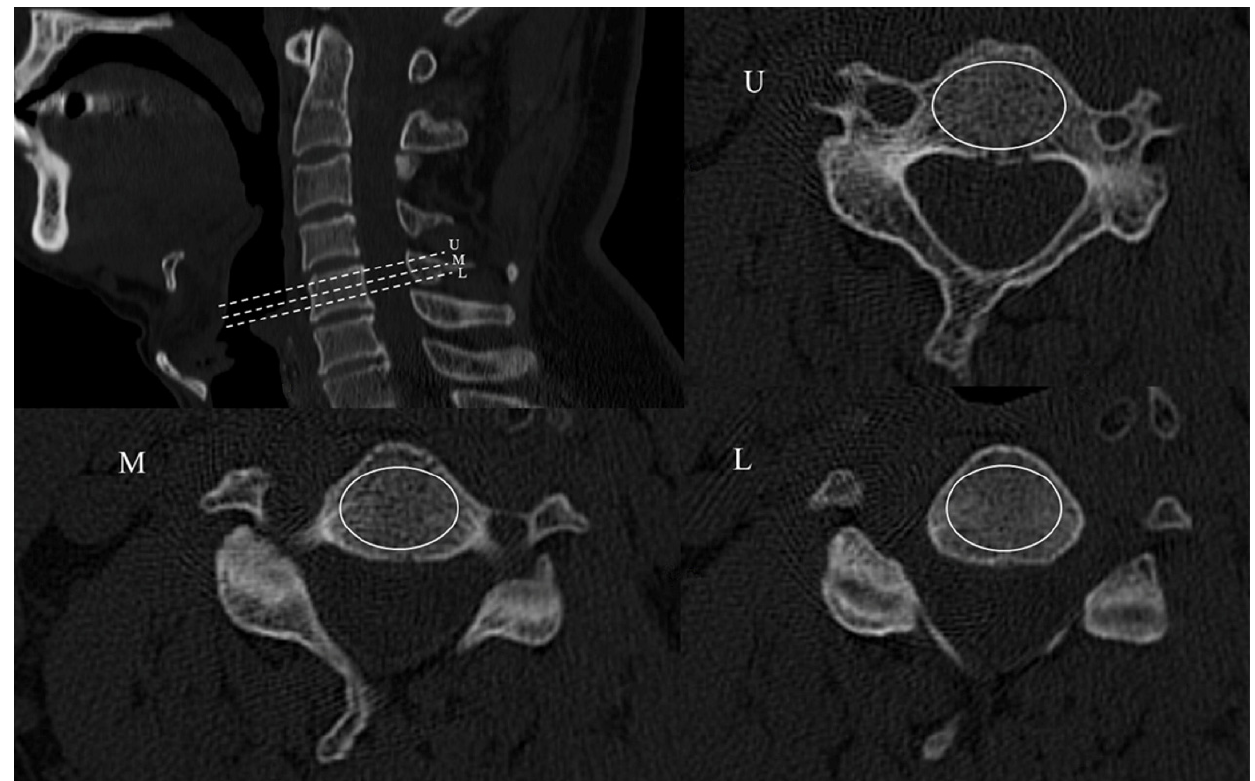
Figure 2 . HU value measurements of cervical body on three slices: U. 2 mm below the superior endplate; M. in the middle of the vertebral body; L. 2 mm above the inferior endplate. The white oval represents the region of interest of the vertebral body on the axis plans.